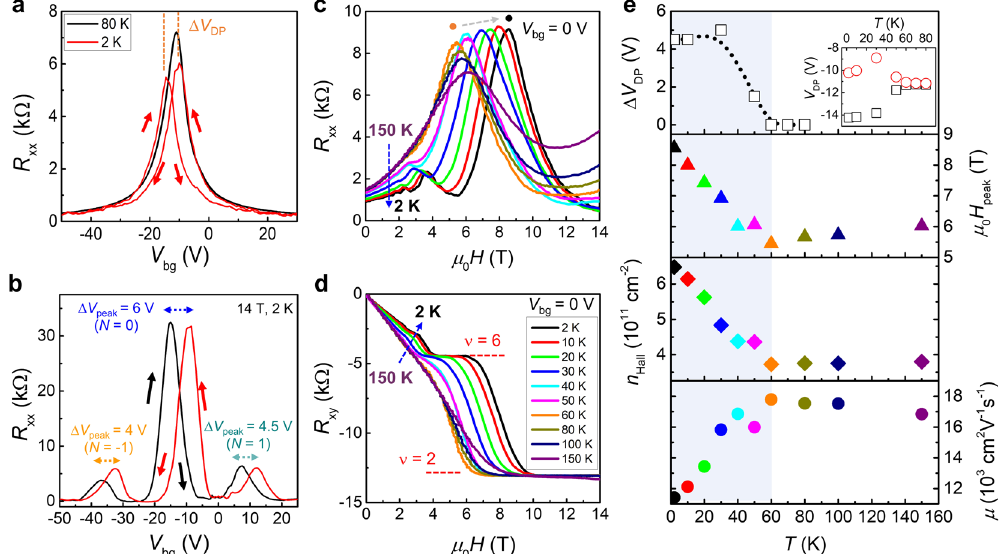
Fig. 3 Probing phase transition of CGT using temperature-dependent transport of D1. a R xx vs. V bg with 0 T at 80 K (black) and 2 K (red). b R xx vs. V bg with 2 K and 14 T, depending on sweeping direction. N indicates the Landau level index and Δ V peak is the difference in the peak position for each N . c , d Temperature-dependent R xx and R xy vs. μ 0 H with V bg = 0 V. e Temperature dependence of the extracted transport parameter Δ V DP , which is obtained from the difference of V DP for forward- (black squares) and backward- (red circles) gate sweeping in the inset. The black-dotted line is to guide the eye. μ 0 H peak corresponds to the local maxima depicted by the dots in ( c ). Hall carrier density n Hall is extracted by linear fi tting from − 1 T to 1 T of R xy vs. μ 0 H in ( d ). Mobility μ is calculated using the Drude model, where R xx in Fig. 1d and n Hall in Fig. 3e are